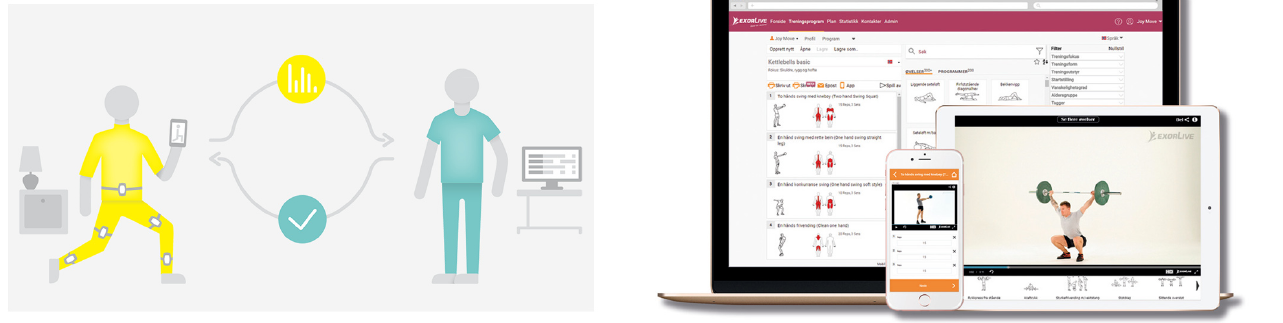
Figure 1. Home-based telerehabilitation using ICURA. Figure 2. Home-based rehabilitation using